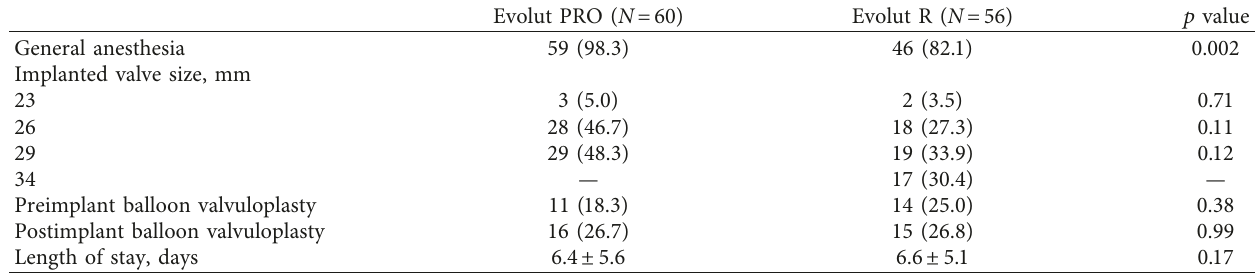
Table 2: Procedural outcomes.